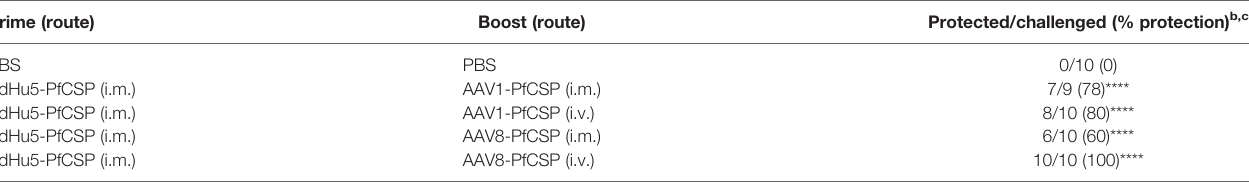
TABLE 1 | Protective ef fi cacies against sporozoite challenge by immunization with heterologous prime-boost regimens in mice a . Prime